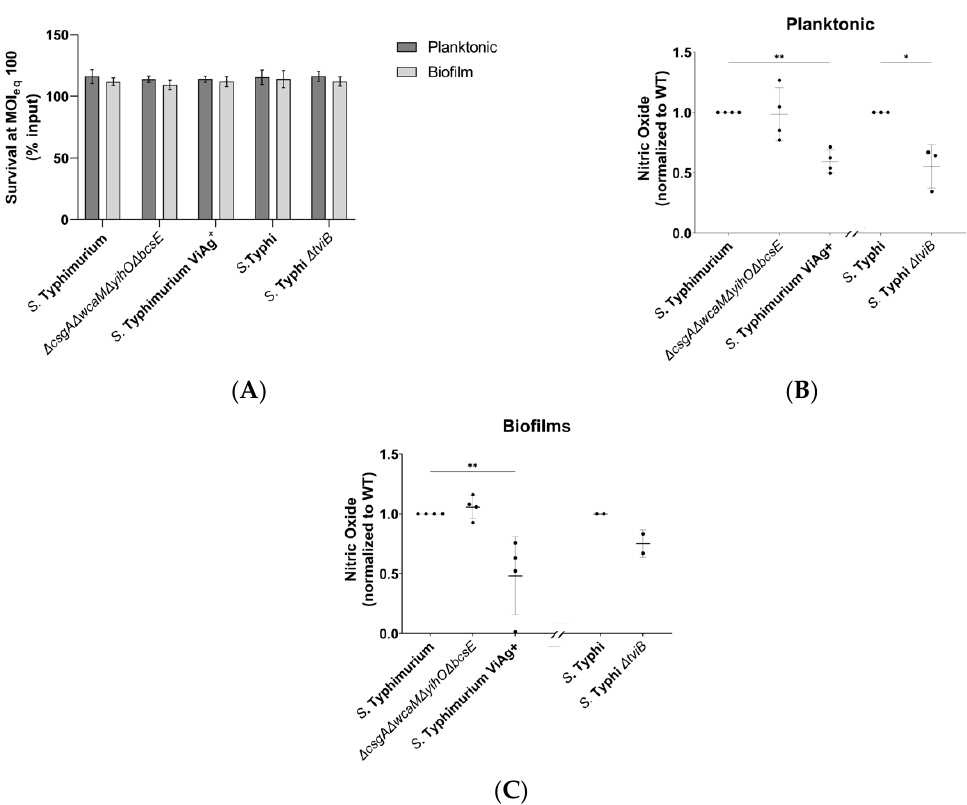
Figure 3. Effect of planktonic and biofilm-associated Salmonella on macrophage nitric oxide (NO) production. JSG4383 used for WT S. Typhi. ( A ) Planktonic and biofilm aggregate survival determined by CFU enumeration after 2-hour incubation with THP-1 macrophages. Analysis by two-way ANOVA with Sidak correction for multiple comparisons demonstrated no difference in CFU viability between growth states ( n = 4, daily enumeration conducted in triplicate). ( B , C ) NO production by THP-1 macrophages after 2-hour infection with planktonic or biofilm-aggregate Salmonella. Significance for S. Typhimurium experiments was determined by ordinary one-way ANOVA with Dunnett correction for multiple comparisons (**, P < 0.005). S. Typhi significant differences were identified by unpaired t test (*, P < 0.05) ( n = 4, daily experiments conducted in duplicate). Error bars indicate SD.